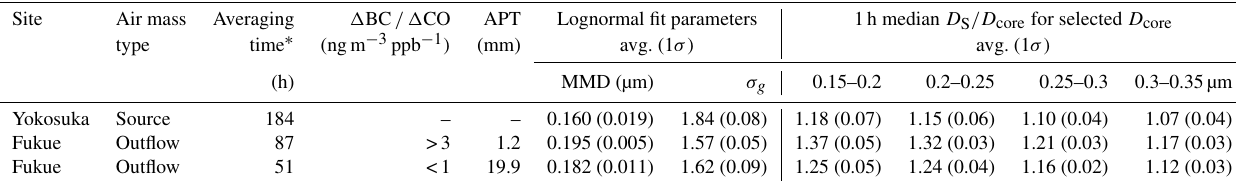
Table 2. Summaries of BC microphysical parameters measured at Yokosuka and Fukue Island.